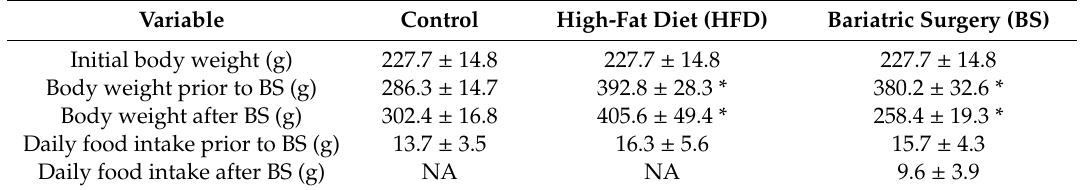
Table 3. Basal biological parameters of the rats. * p < 0.05 vs.